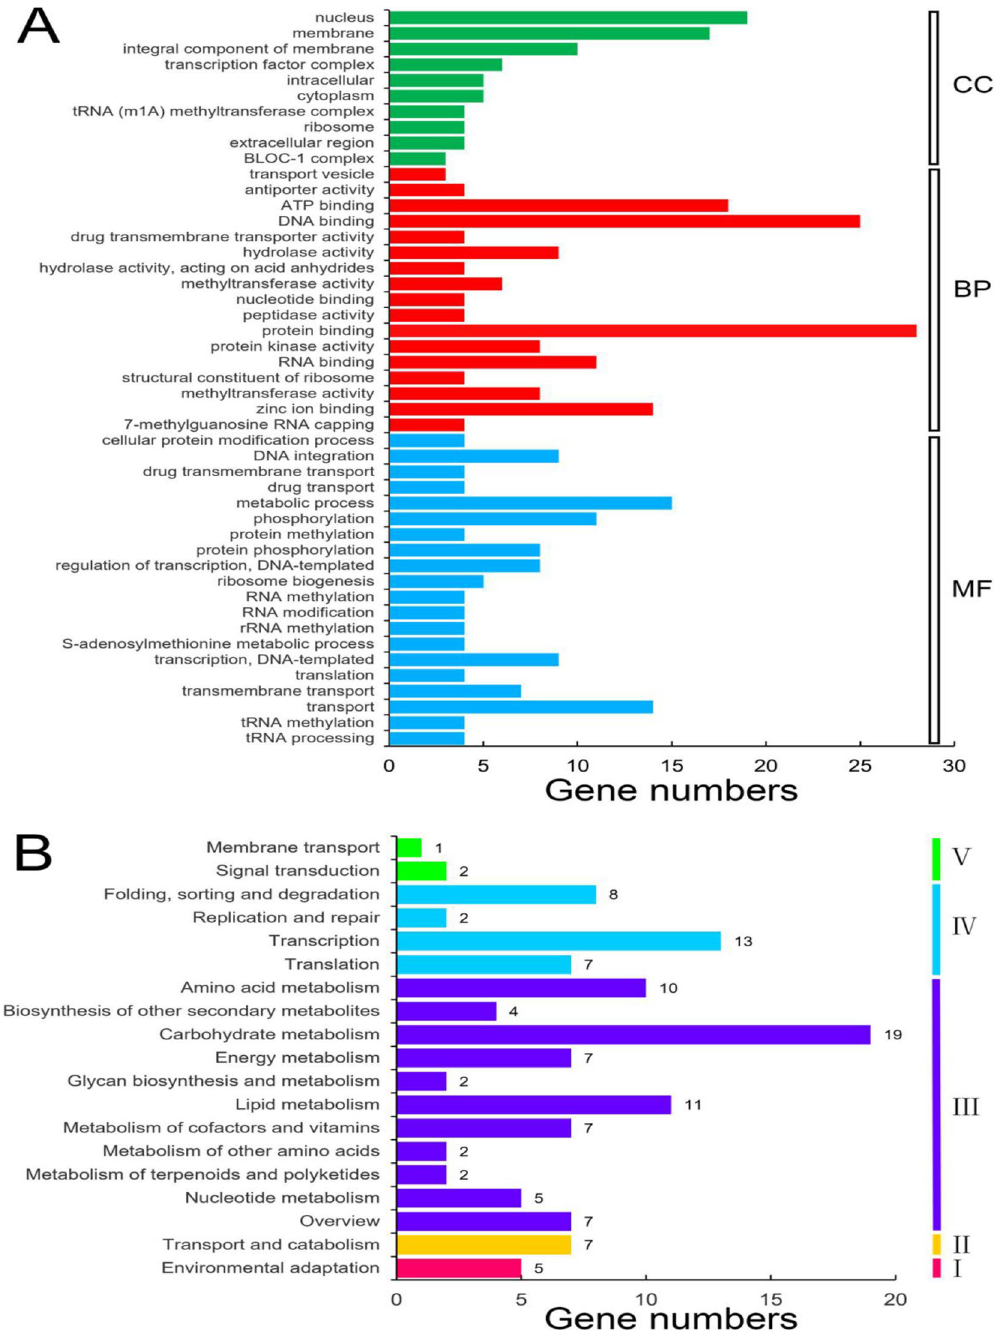
Figure 5. Gene Ontology ( A ) and KEGG ( B ) classifications of DE miRNA targets. CC cellular component, BP biological process, MF molecular function, I organismal systems, II cellular processes, III metabolism, I genetic information processing, V environmental information